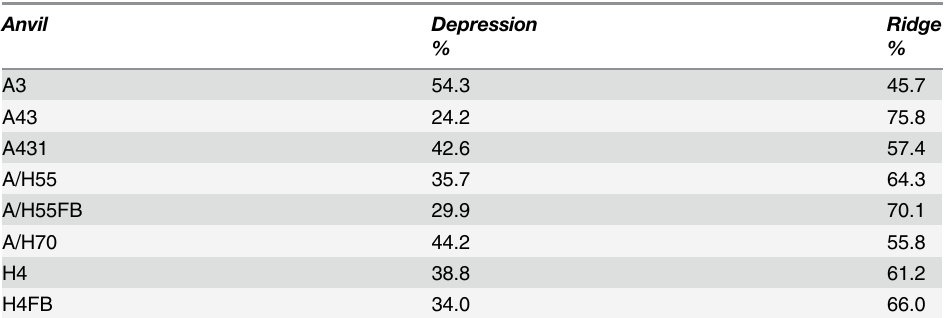
Table 3. Percentage of lowest roughness areas (values of roughness fi nal model < 0.01) in the depressions and ridges identi fi ed in the artifact surfaces using the Topographical Position Index